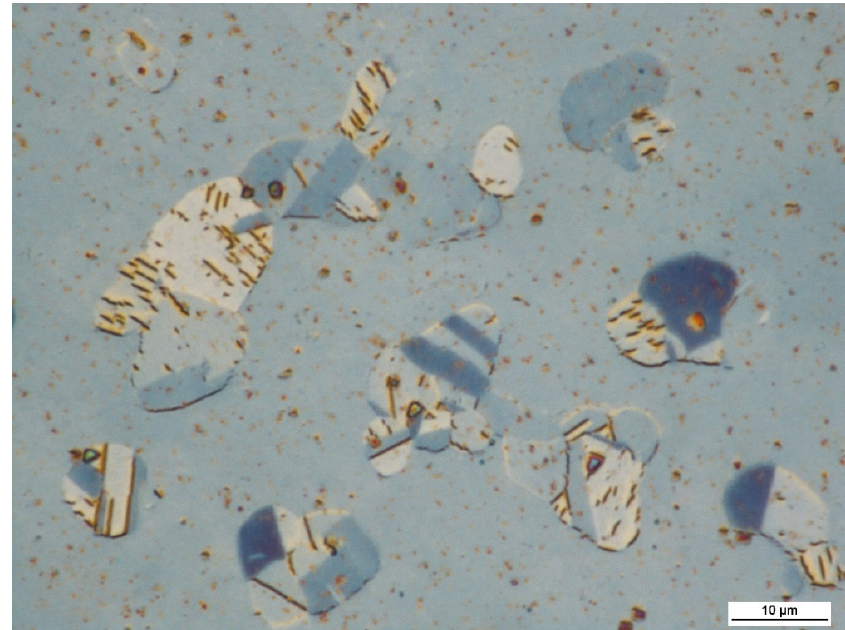
Figure 13. Microstructure of X120Mn12 steel after re-austenitisation at 900 °C. Sample previously isothermally annealed at 510 °C and cooled with furnace. Numerous new austenite grains of less than 20 μ m in size can be seen with characteristic twin grains boundaries and fine, evenly distributed carbide precipitations. Etched state. LM.